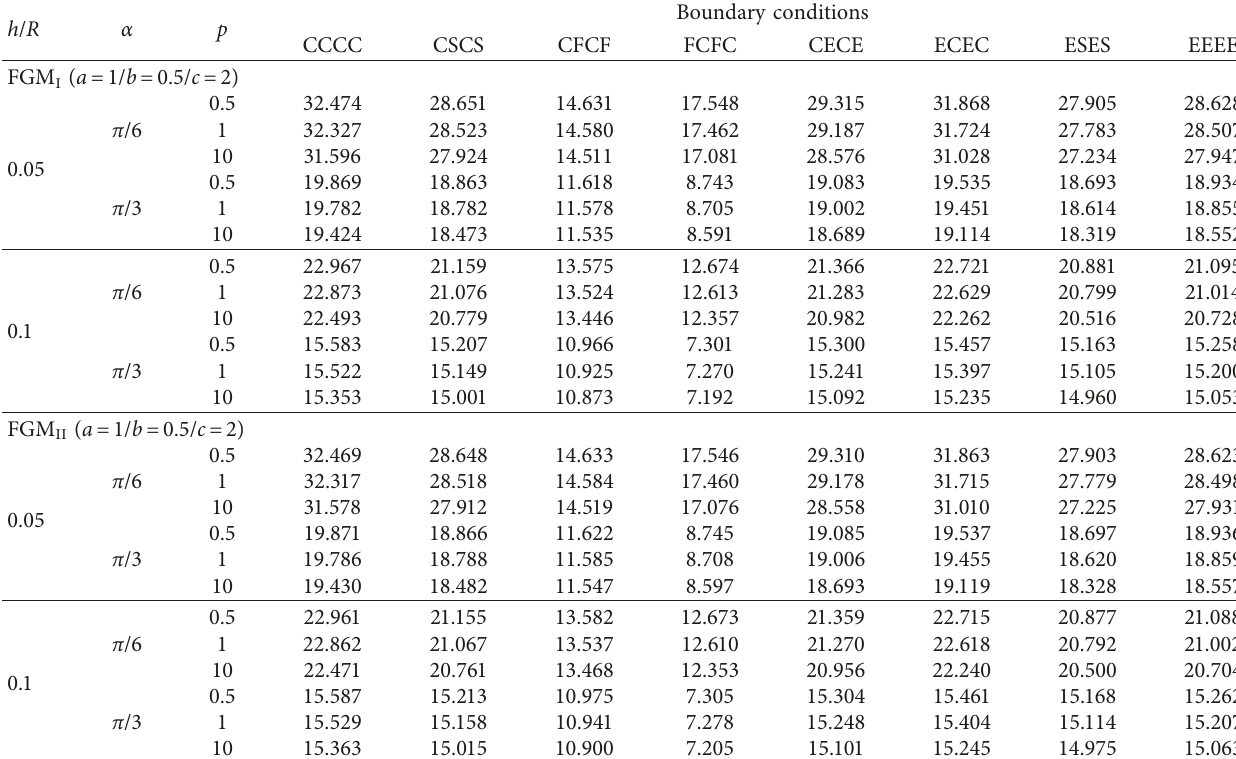
Table 8: Fundamental frequency parameters for FGOS with two axial bulkheads and various boundary conditions ( R � 1 m, L